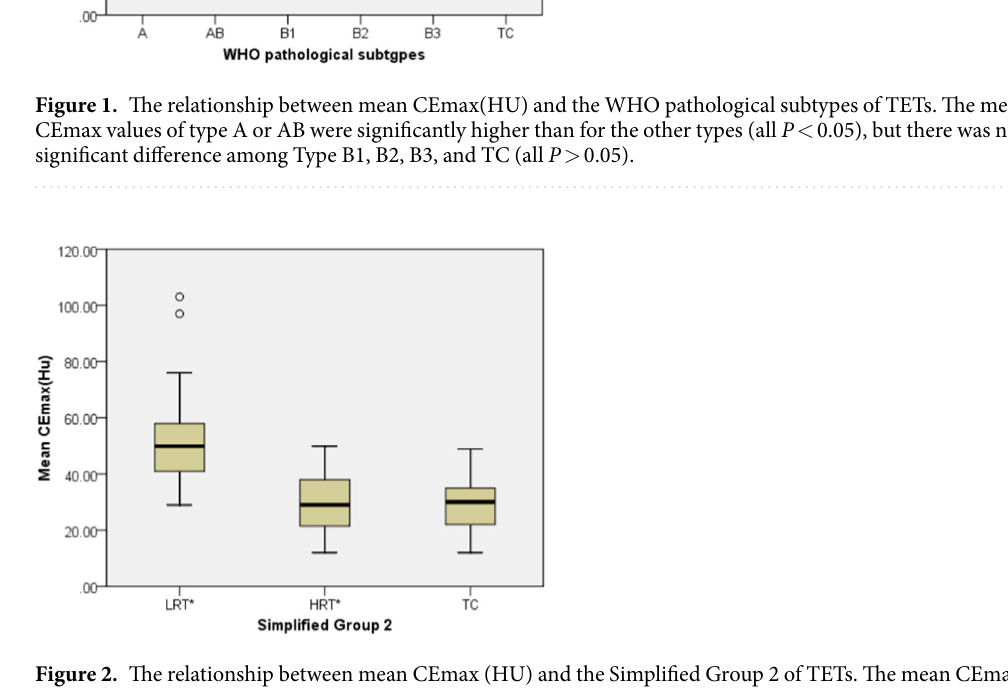
Figure 2. The relationship between mean CEmax (HU) and the Simplified Group 2 of TETs. The mean CEmax values of LRT * were significantly higher than that for HRT * and TC (all P < 0.001), but there was no significant difference between HRT * and TC ( P =